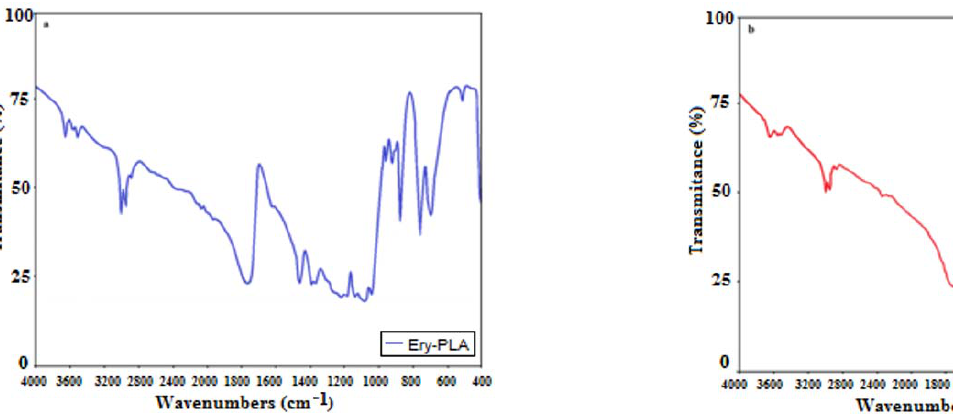
9 of 12 Figure 10. Thermal analysis graph of ( A ) erythromycin (Ery), PLA, and erythromycin ‐ loaded PLA (Ery ‐ PLA); ( B ) erythromycin (Ery), PLGA, and erythromycin ‐ loaded PLGA (Ery ‐ PLGA). Furthermore, the thermographs also revealed a reduction in both PLA and PLGA transition temperature concerning nano ‐ encapsulation of erythromycin due to increase of particles size, in the case of which glass transition temperature is inversely proportional to the amorphous polymers particle size. FTIR spectra (Figure 11) of Ery ‐ PLA and Ery ‐ PLGA nano ‐ architectures revealed chemical structure of drug ‐ loaded polymer nanoparticles and peaks were almost similar. FTIR data revealed that Ery ‐ PLGA nanoparticles’ peaks were around 3650 cm − 1 and 3500 cm − 1 due to O ‐ H stretching vibrations, at near 2950 cm − 1 and 2990 cm − 1 assigned to C ‐ H stretch vibrations, 1760 cm − 1 to C=O, 1460 cm − 1 attributed to C ‐ H binding, 1390 cm − 1 to